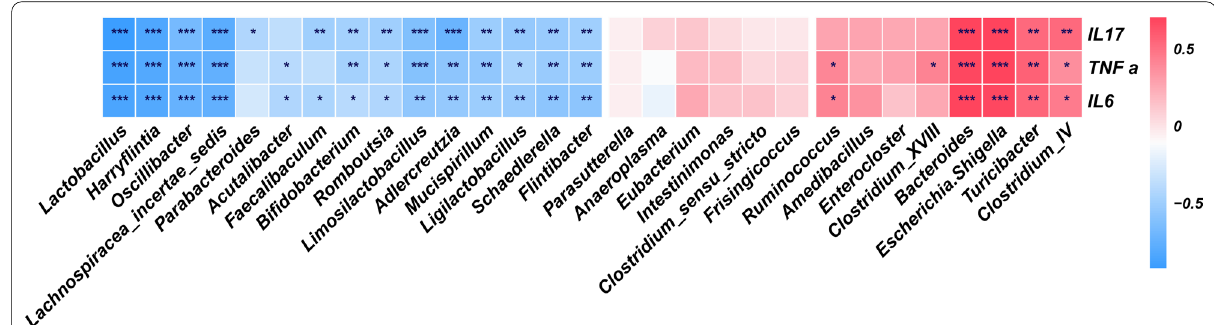
Fig. 7 Correlation analysis between gut microbiota and inflammatory